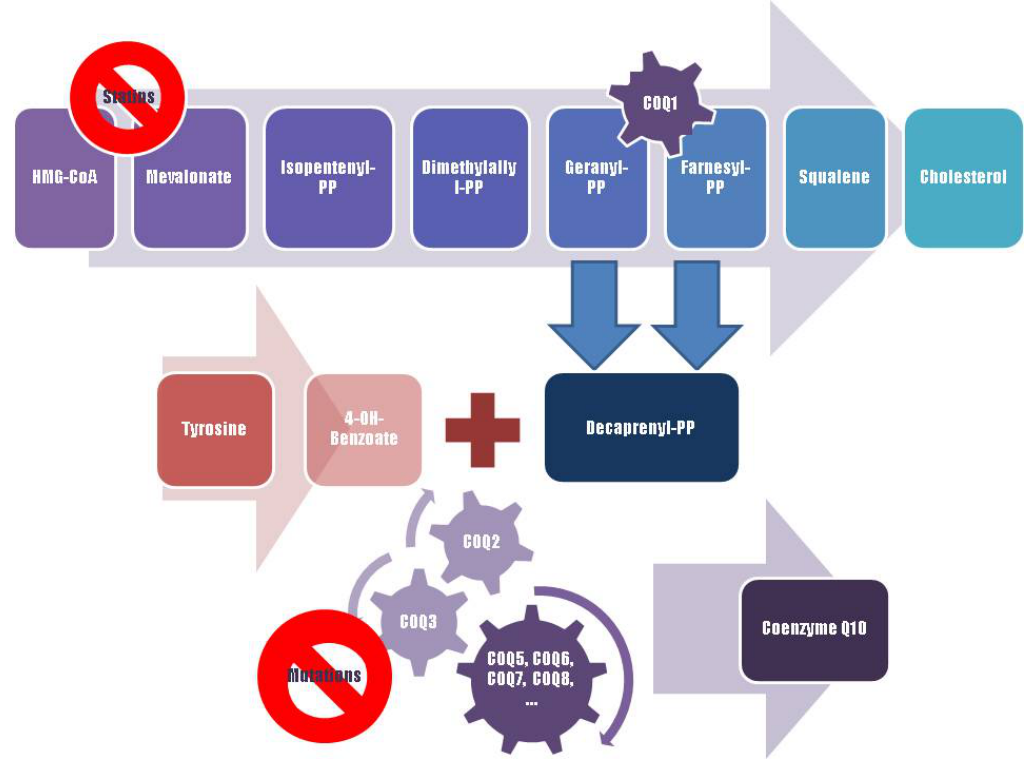
Figure 2. A schematic representation of Coenzyme Q10 biosynthesis. The sequence of cellular reactions that leads to farnesyl-PP is the mevalonate pathway. Farnesyl-PP is the common substrate for the synthesis of cholesterol, dolichol, and Coenzyme Q10, as well as for prenylation of proteins. Coenzyme Q10 contains also a benzoate ring originating from tyrosine. 3-hydroxy-3-methylglutaryl coenzyme A (HMG-CoA) reductase inhibitors, or statins, block production of mevalonate, a critical intermediary in the cholesterol synthesis pathway. A hypothesized mechanism of statin myopathy involve mitochondrial dysfunction caused by reduced intramuscular coenzyme Q10. After 4-OH-benzoate and decaprenyl-PP are produced, at least seven enzymes (encoded by COQ2-8 genes) catalyze condensation, methylation, decarboxylation, and hydroxylation reactions needed to synthesize Coenzyme Q10. Abnormalities in any part of this metabolic cascade will cause primary CoQ10 deficiency. PP,